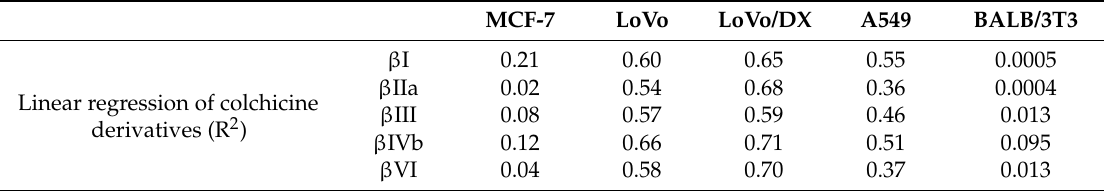
Table 6. Linear regressions involving two independent variables (binding energy by MM/GBSA method and MlogP) of the investigated colchicine derivatives versus log IC50 ( µ M) in different cancer cell